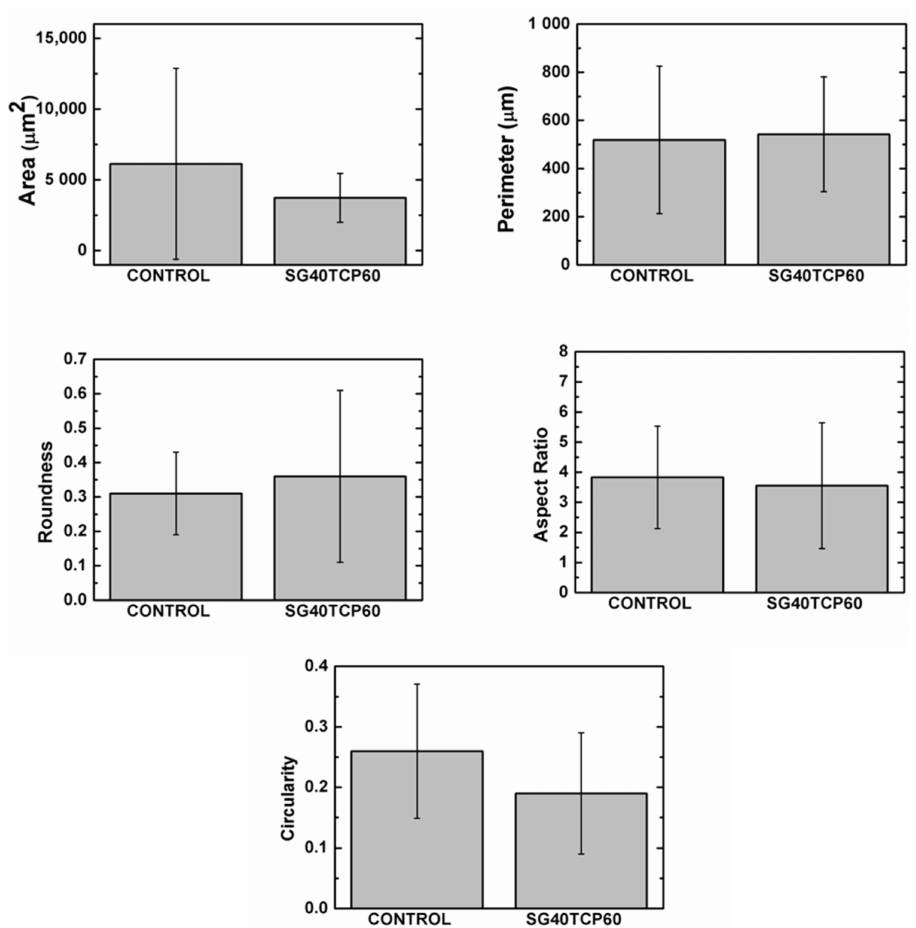
Figure 10. Quantitative data for shape parameters after 48 h. One-way analysis of variance. Statistical significance p <